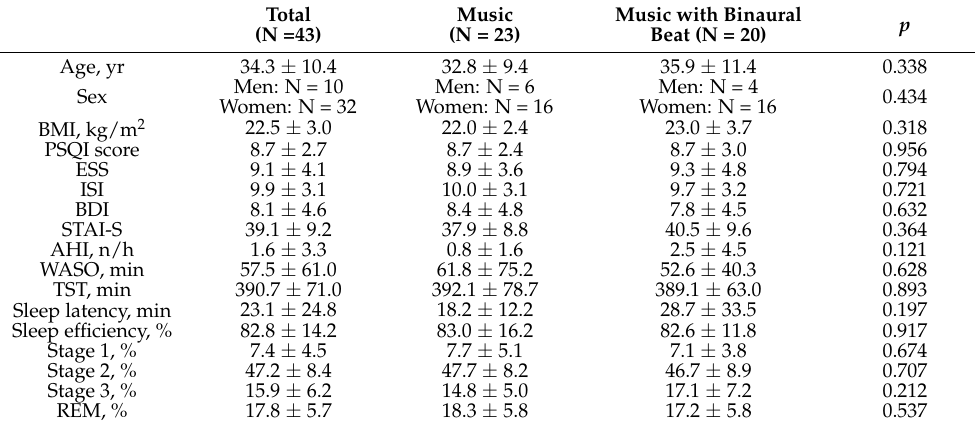
Table 1. Demographics and polysomnographic findings of eligible